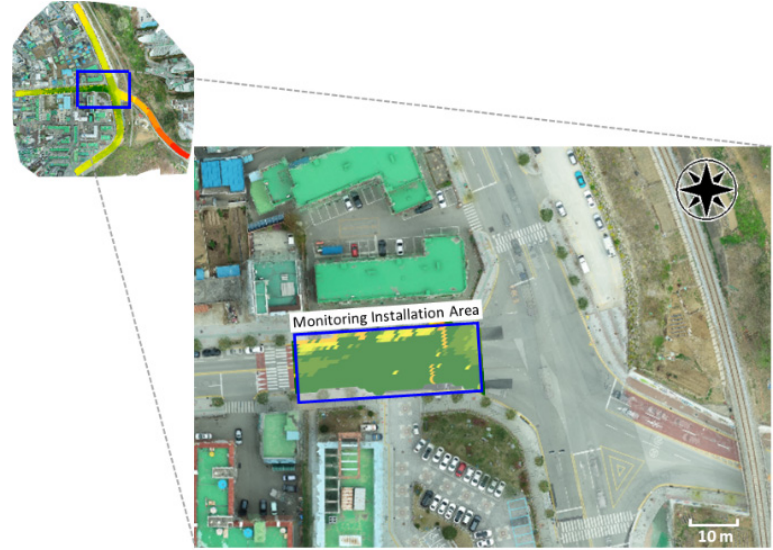
Figure 14. Selection of the monitoring point.